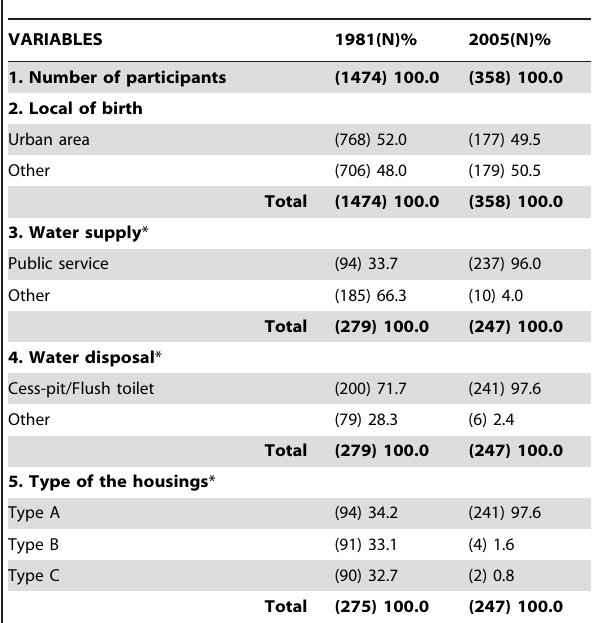
Table 1. Comparative data of the socioeconomic survey carried out in Comercinho/MG, Brazil